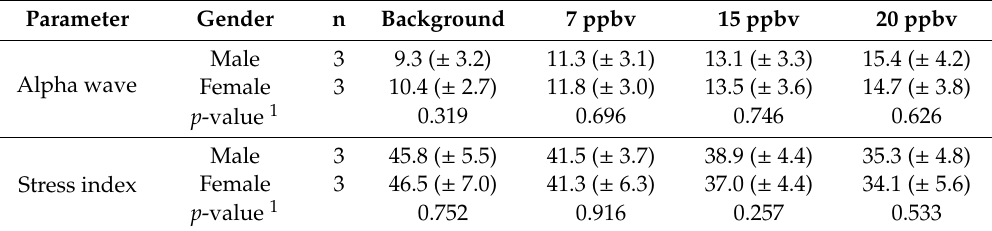
Table 6. Mean values of alpha wave and stress indexes of male and female participants obtained from Exp